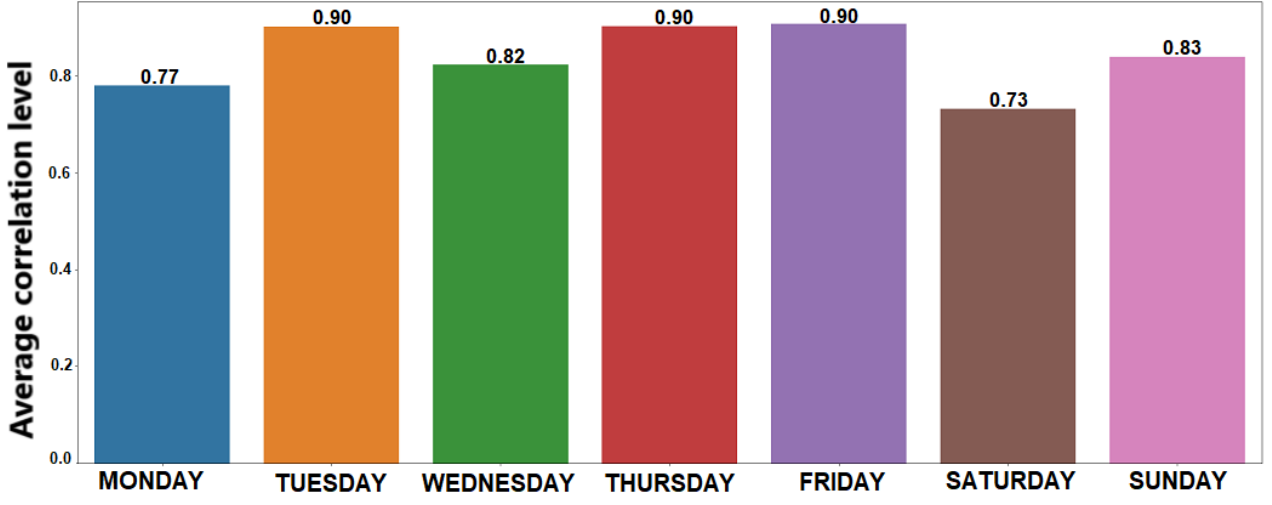
Figure 15. Average correlation level for each